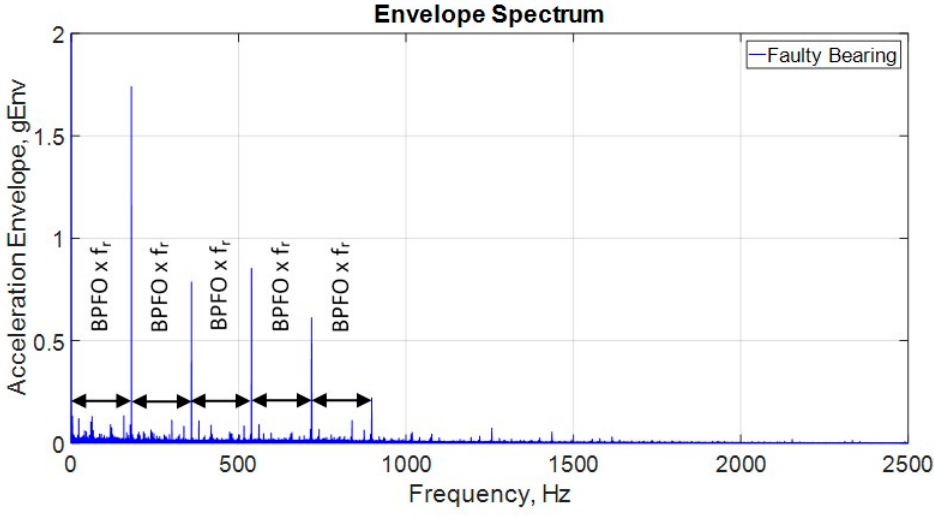
Figure 4. Acceleration envelope spectrum for the faulty bearing.